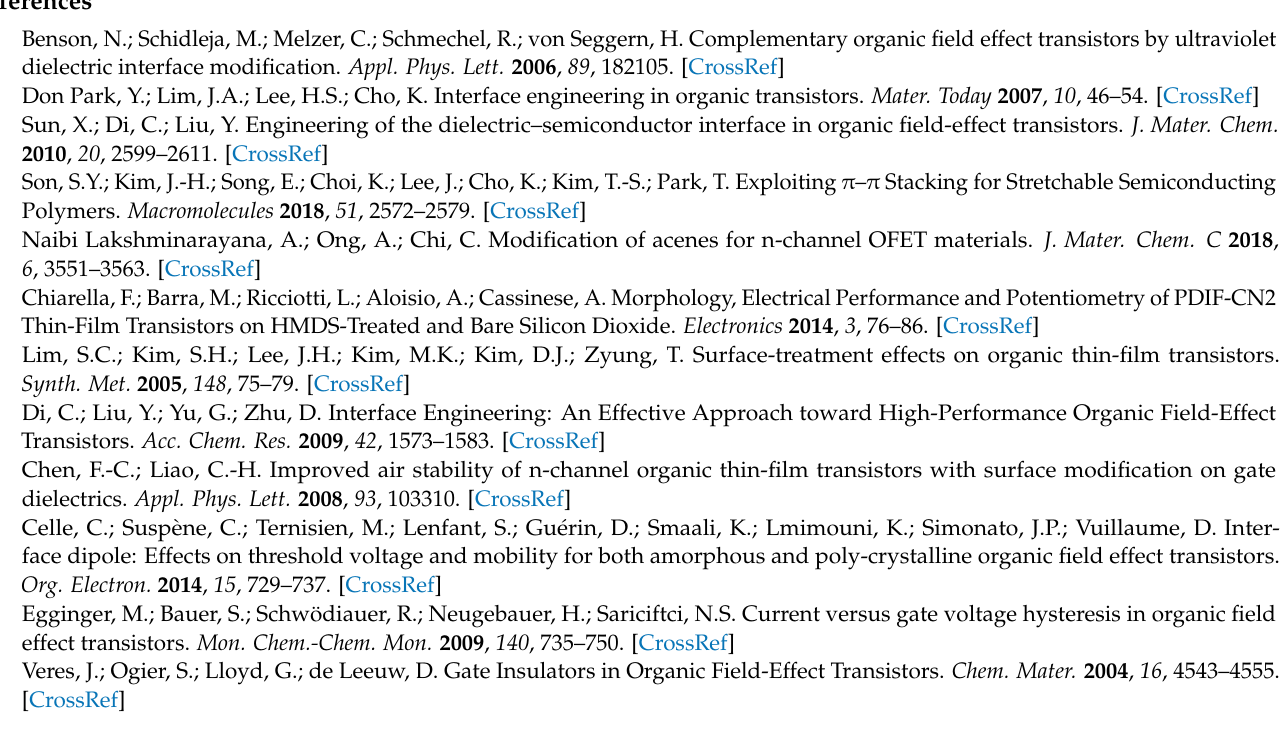
Figure S4: 13 C NMR (100 MHz, CDCl 3 ) of compound 2. Figure S5: Infrared spectrum of compound 1. Figure S6: Infrared spectrum of compound 2 . Figure S7: HRMS spectrum of compound 1 . Figure S8: HRMS spectrum of compound 2 . Figure S9: SEM picture of the cross-section of the BQMI 3 spin- coated layer on a silicon wafer. Figure S10: AFM picture of the BQMI 1 spin-coated layer on a silicon wafer. Figure S11: AFM picture of the BQMI 3 spin-coated layer on a silicon wafer. Figure S12: AFM picture of the BQMI 4 spin-coated layer on a silicon